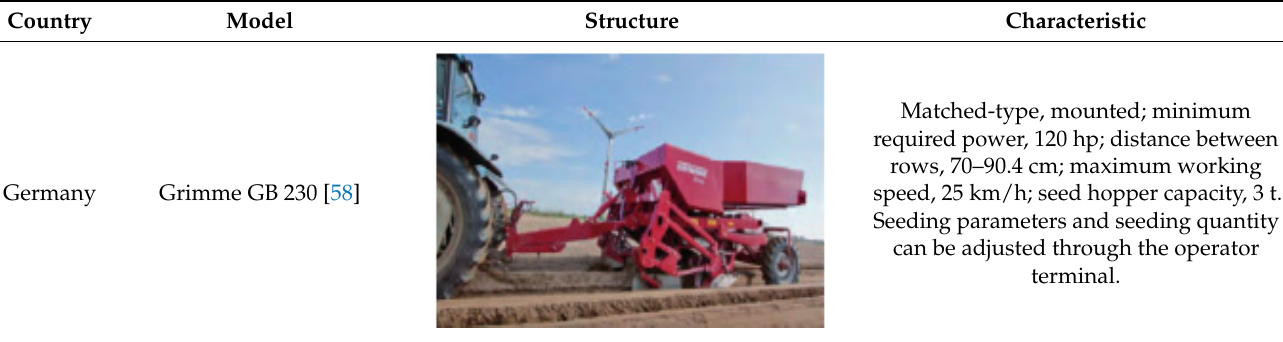
Table 7. Introduction of moving-belt-type Planter.